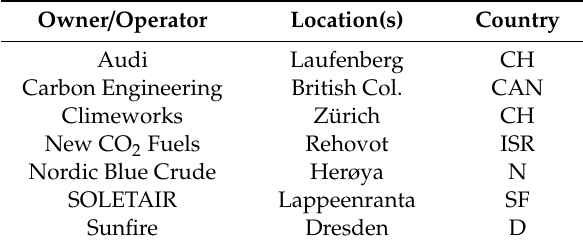
Table 12. Companies pursuing atmospheric-carbon-to-fuels. Owner / Operator Location(s) Country